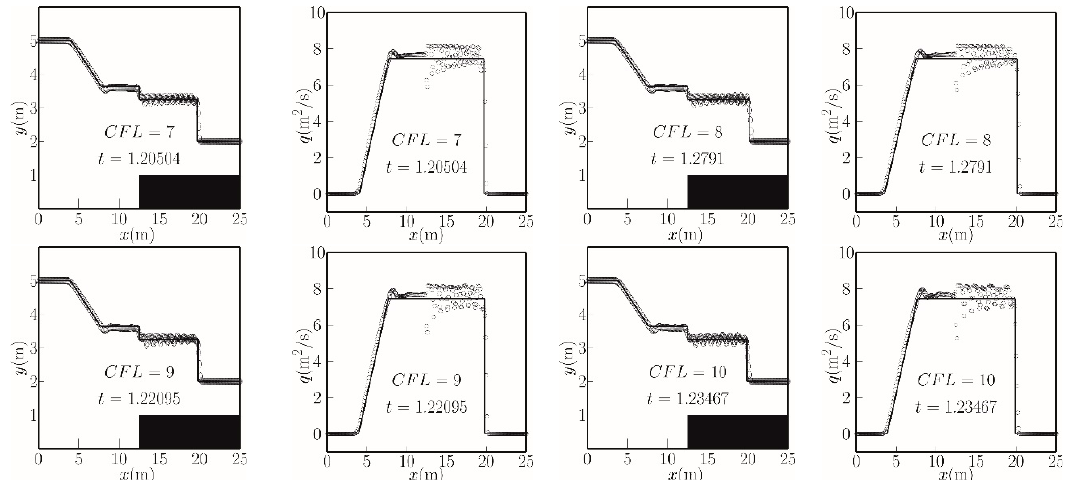
Figure 6. Free surface and mass flux profiles for a single rarefaction and a single shock in a channel containing a bed step at a given time instant. Rosatti and Begnudelli [23]’s analytical solution (solid lines), well-balanced scheme [22] (red circles), and TVD-LTS predictions (open circles) for CFL = 1 to 10. The solid rectangle indicates the bed shelf.